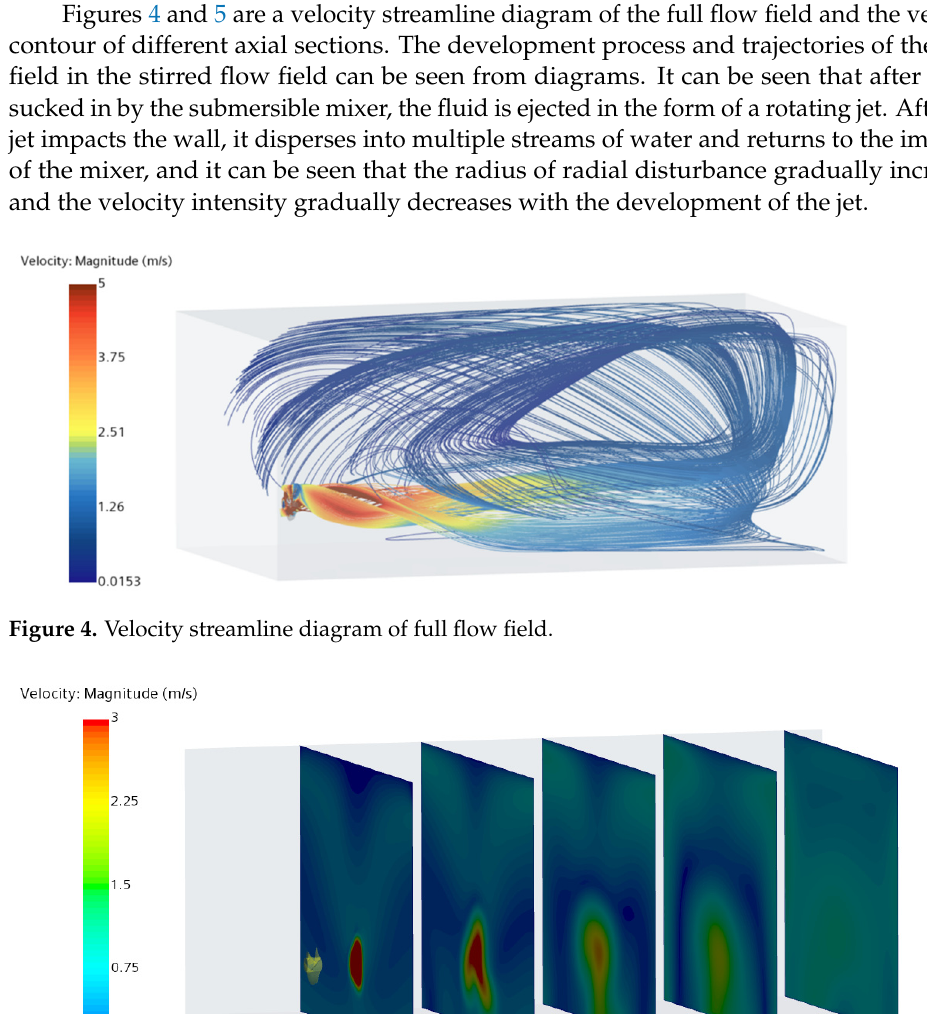
Figure 3. The velocity and turbulent kinetic energy bubble plots of four axial planes along Z-axis direction: ( a ) Y = 0 plane; ( b ) Y = − 0.3 plane; ( c ) Y = − 1 plane; ( d ) Y = − 1.3 plane.